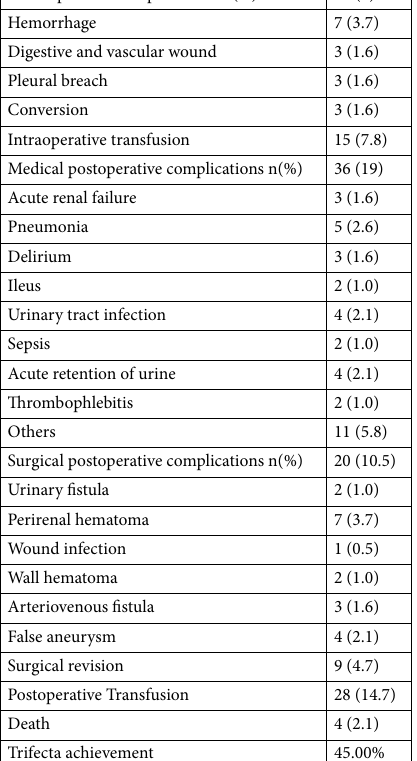
Table 3. Details of